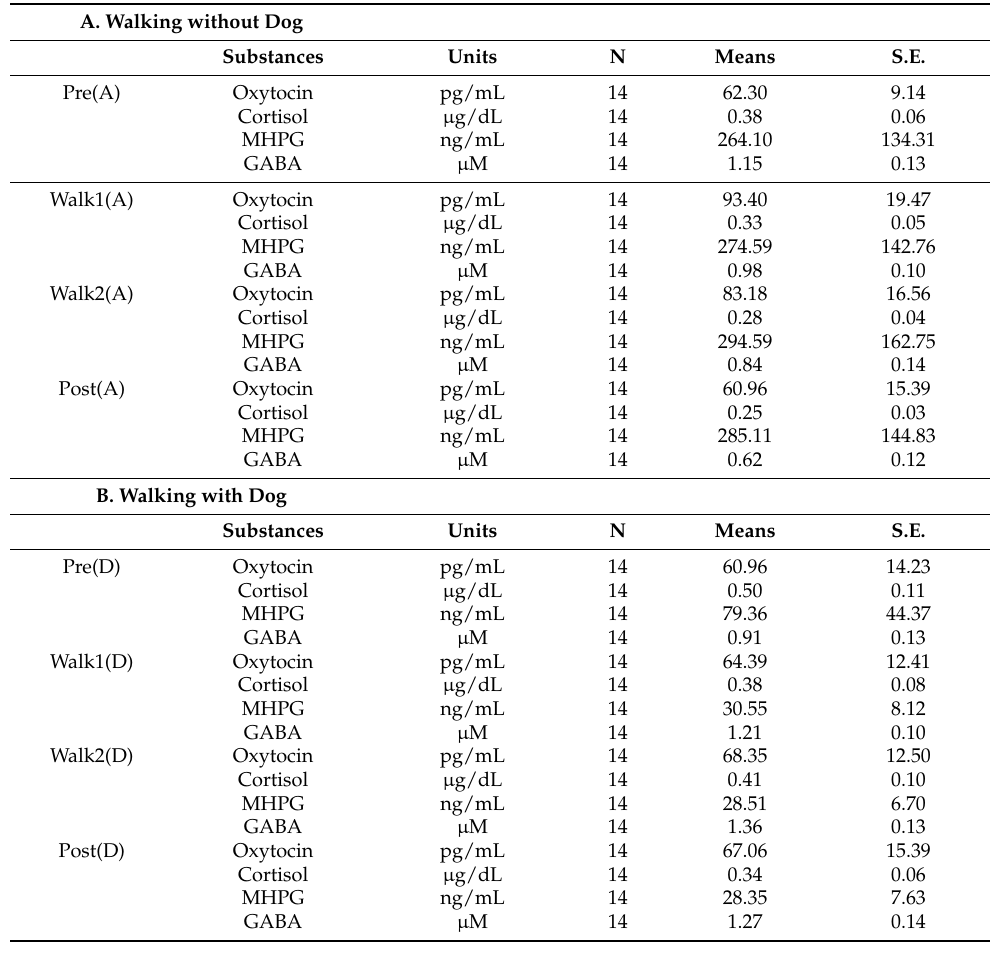
Table 3. The concentrations of oxytocin, cortisol, MHPG, and GABA during walk alone ( A ) or walk with dog ( B ) in Experiment II.